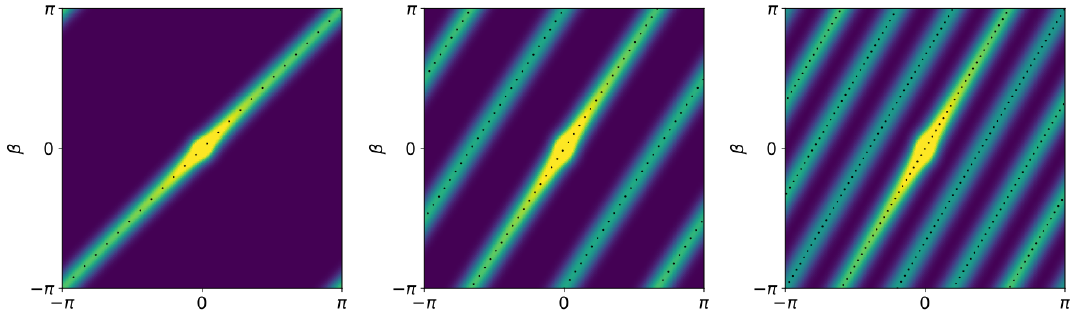
Figure 7: The norm | K ( x , x (cid:48) ) | , computed numerically thanks to eq. (18), for bound- ary points whose complex coordinates (19) have θ = π/ 2. All three plots represent a torus whose horizontal and vertical axes are respectively α , β . Yellow denotes higher norms, navy blue lower ones; intermediate colors interpolate. From left to right, anisotropy ratios are ∆ = 1, 3 / 2, 5 / 3 (respectively with 45150, 30200, 27210 par- ticles). The localization on the guiding center trajectories of fig. 2 (here shown as black dots) is